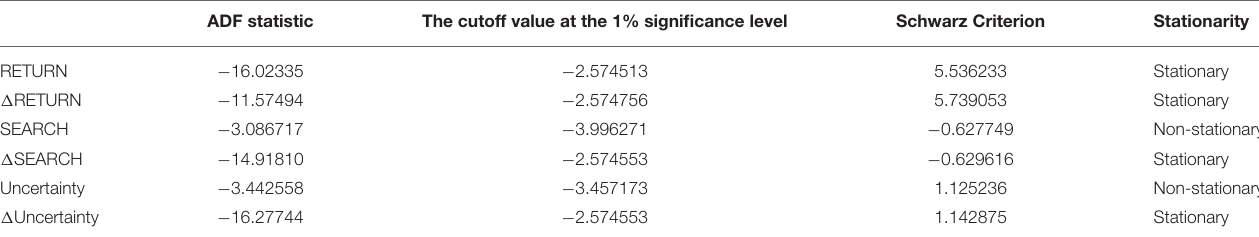
TABLE 2 | ADF test for the main variables.